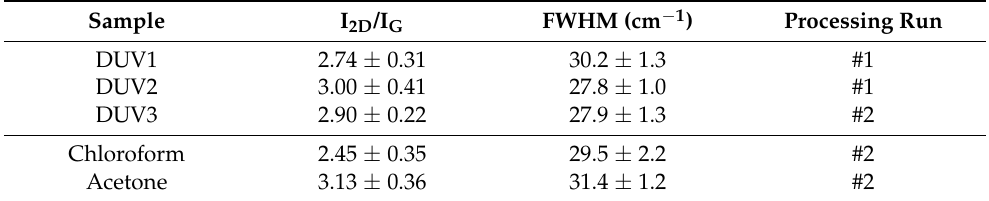
Figure 7. Raman measurements of wet-transferred CVD graphene after PMMA removal: ( a ) Raman spectra of the selected sample DUV3 demonstrating shape and position of G and 2D lines (spectra are shifted vertically for visual clarity). Spectra were measured every 10 μ m steps along a line on the graphene. ( b ) Correlation analysis of the G and 2D peak positions for all samples under study, i.e., 3 DUV method samples (black squares), chloroform sample (green squares), acetone sample (yellow squares), and commercially transferred sample (orange squares). The black solid line demonstrates the dependence correlation between the frequencies of the G and 2D lines in the Raman spectrum of undoped graphene under biaxial strain. Blue dashed lines show correlation dependence for doped graphene under biaxial strain. Black cross marks G and 2D line positions in undoped and unstrained graphene. Table 1. Properties of graphene Raman spectra prepared by different methods.